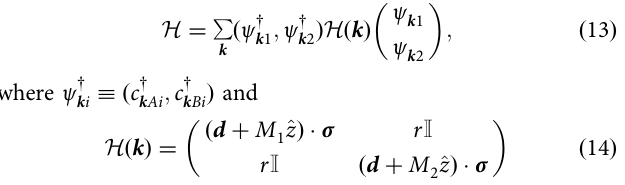
p j d j þ M 1 z j d j (cid:3) M 1 z